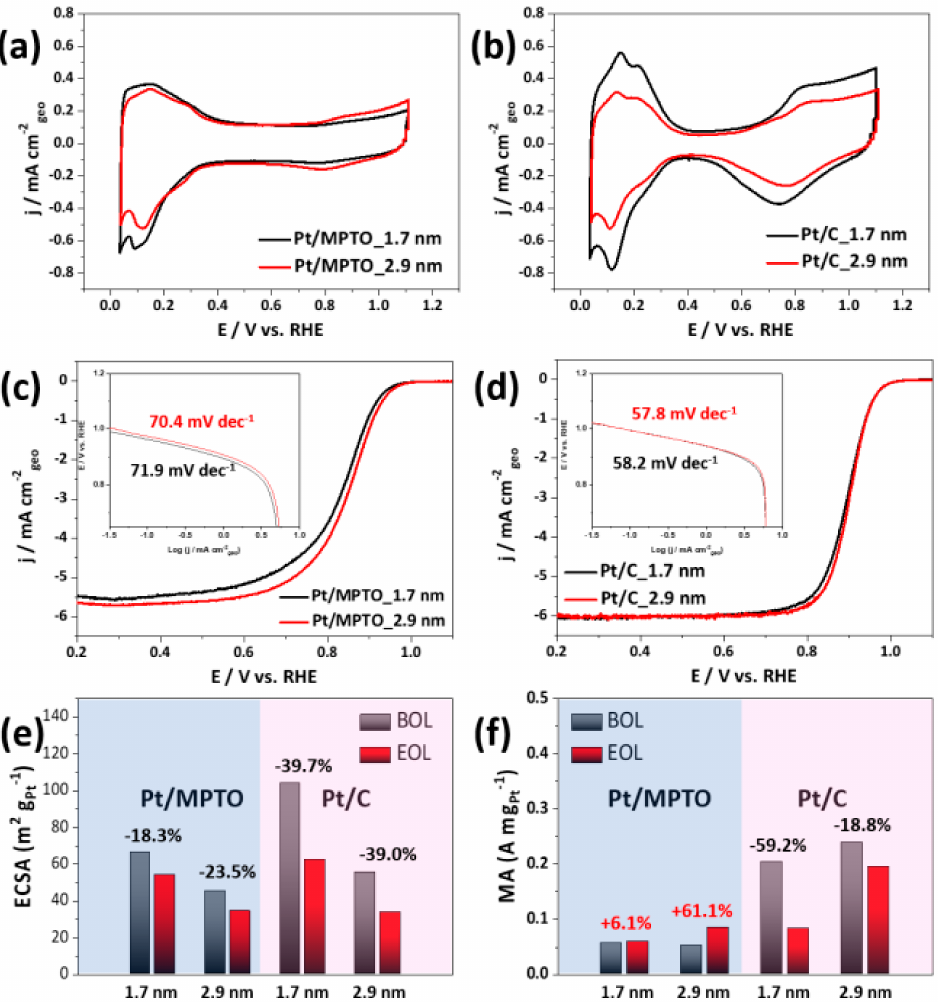
Figure 8. ( a , b ) CVs of Pt/MPTO and Pt/C, ( c , d ) LSVs, ( e ) ECSAs, ( f ) MA at 0.9V of Pt/MPTO and Pt/C. (BOL: beginning of life, EOL: end of